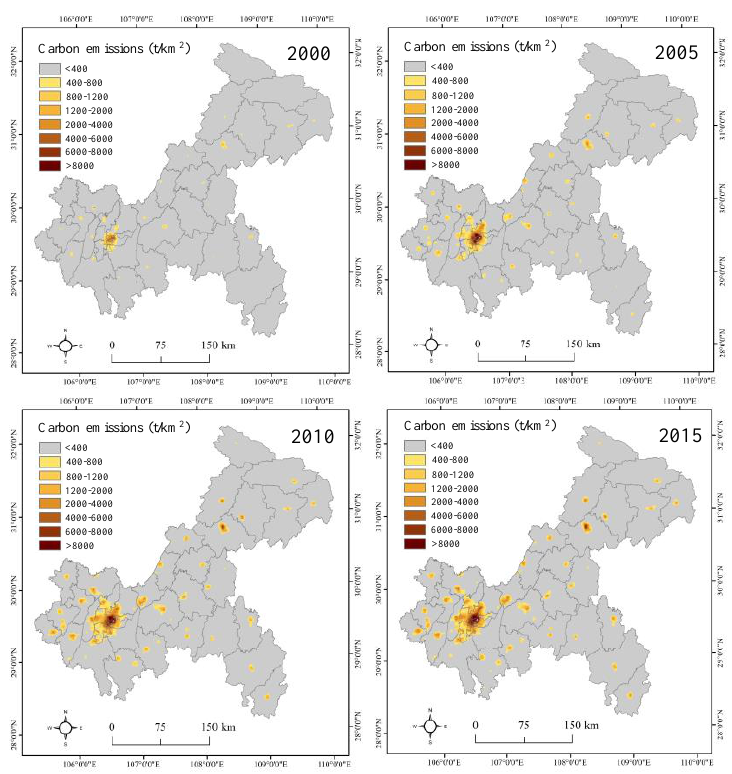
Figure 3. Carbon emissions in Chongqing from 2000 to 2015.